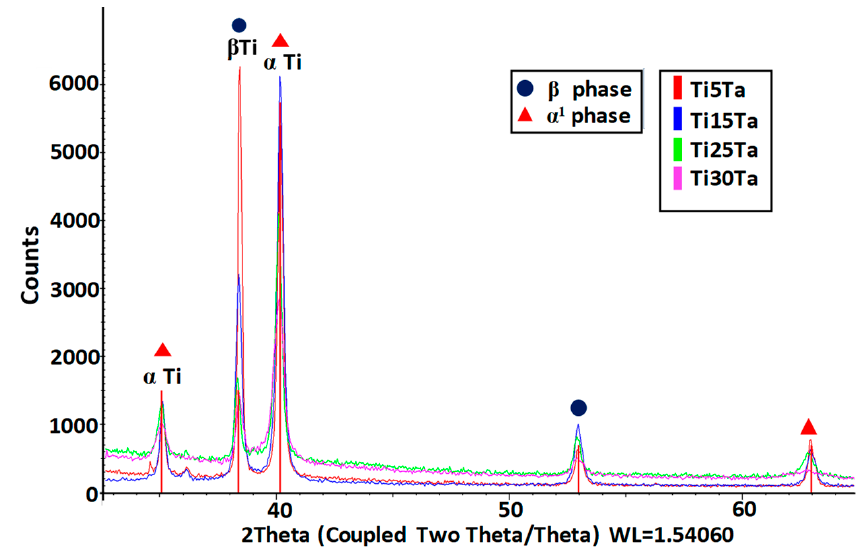
Figure 3. XRD pattern for TixTa alloys.